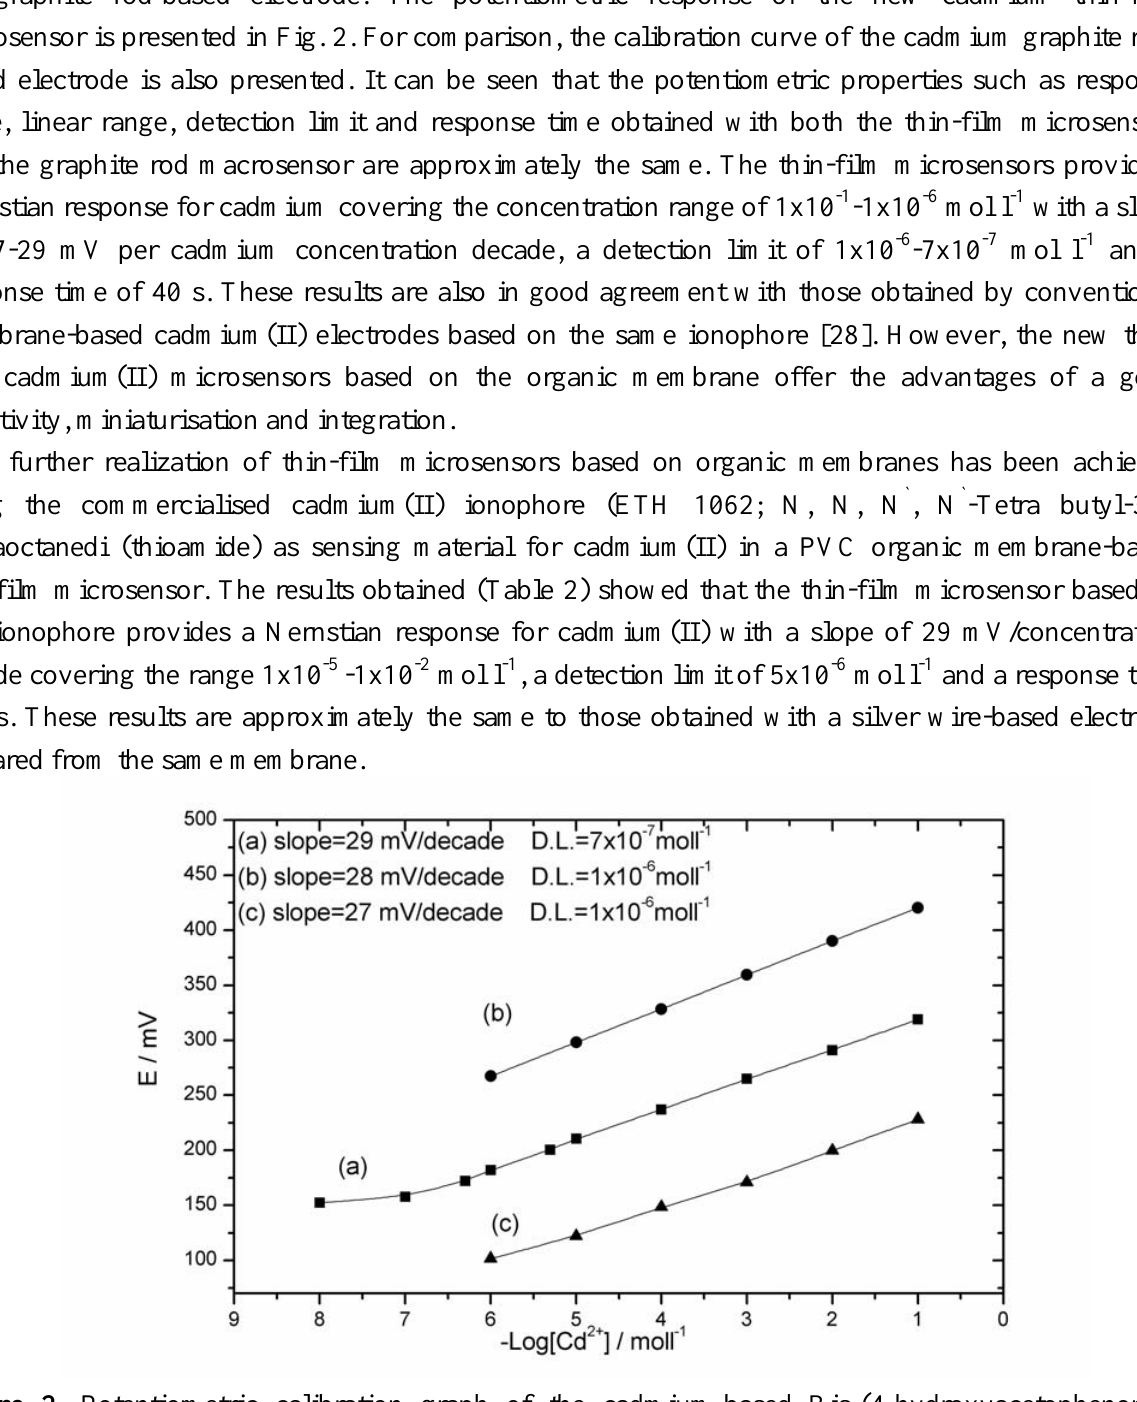
Figure 2. Potentiometric calibration graph of the cadmium-based Bis-(4-hydroxyacetophenone)- ethylenediamine electrode (a: graphite rod, b: Pt microsensor, c: Au